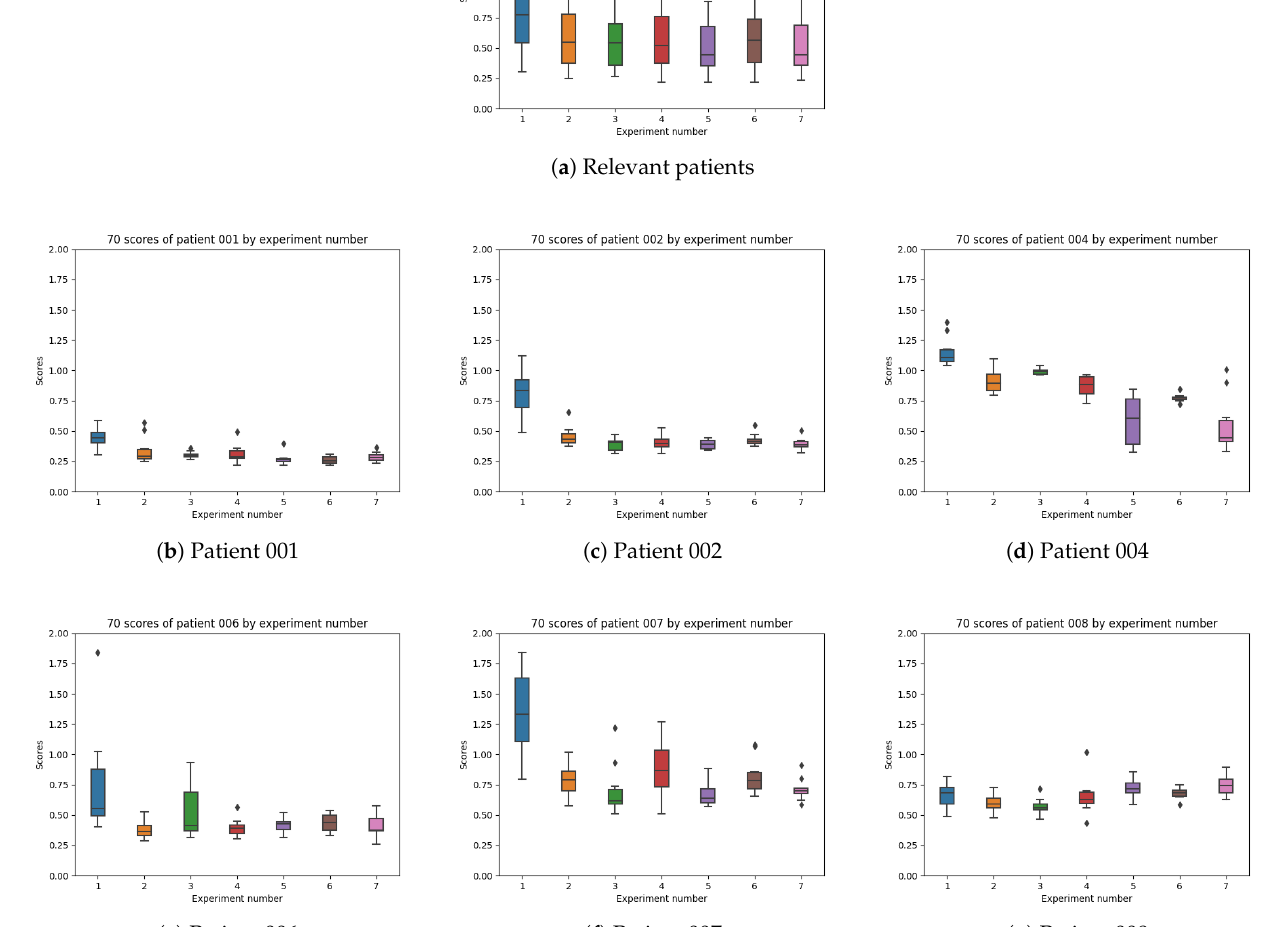
Figure 21. Patients